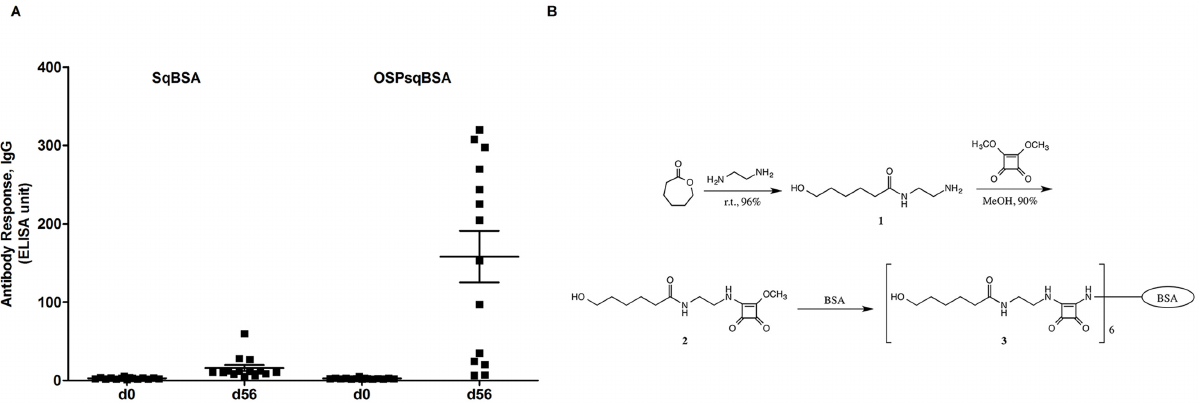
Fig 4. (A) Immune responses against OSP linked to BSA via squarate (ratio ~5:1; OSPsq:BSA) versus an unrelated oligosaccharide linked to BSA via squarate (B; ratio ~6:1; sq:BSA-synthetic conjugate 3, see text) induced by vaccination with alum and OSP linked to rTTHc via squarate (ratio 5:1; OSP:rTTHc). Day 0 and day 56 serum from mice vaccinated with OSP:rTTHc were analyzed using plates coated with squarate-BSA (synthetic conjugate 3; see text) or OSPsq:BSA